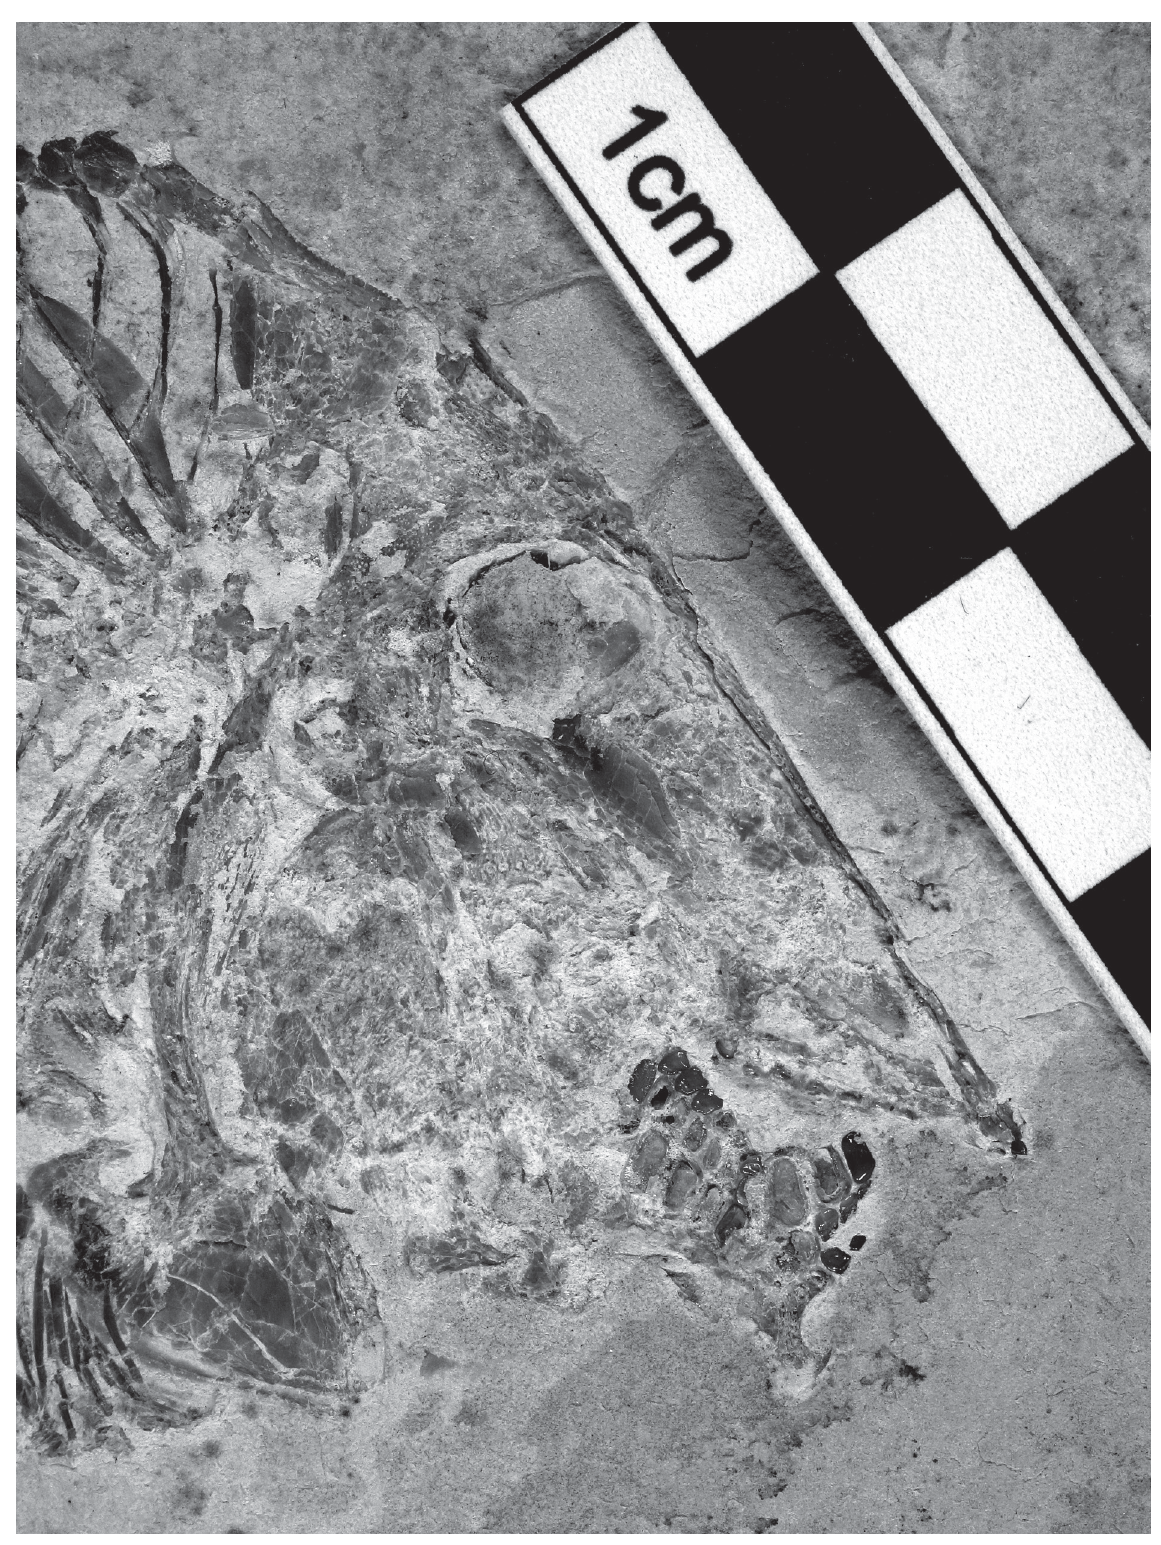
Fig. 3. Libanopycnodus wenzi gen. et sp. nov., holotype, head region (CLC